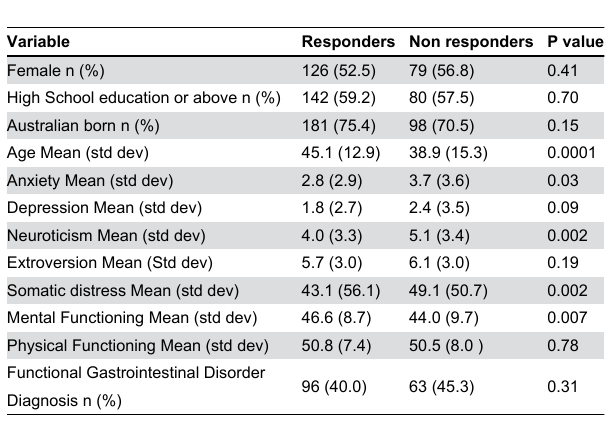
Table 1. Characteristics of responders and non-responders to a 12 year follow up